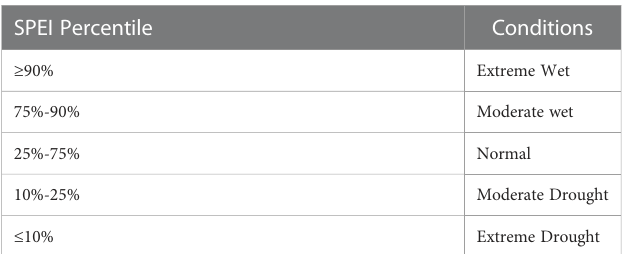
TABLE 2 SPEI percentile threshold for determining water balance conditions.